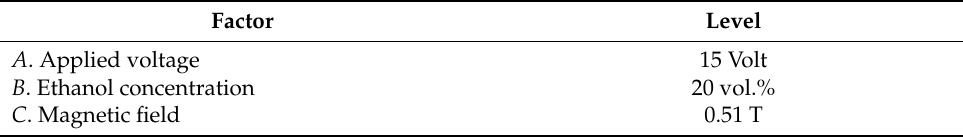
Table 10. Optimal condition for EP process.